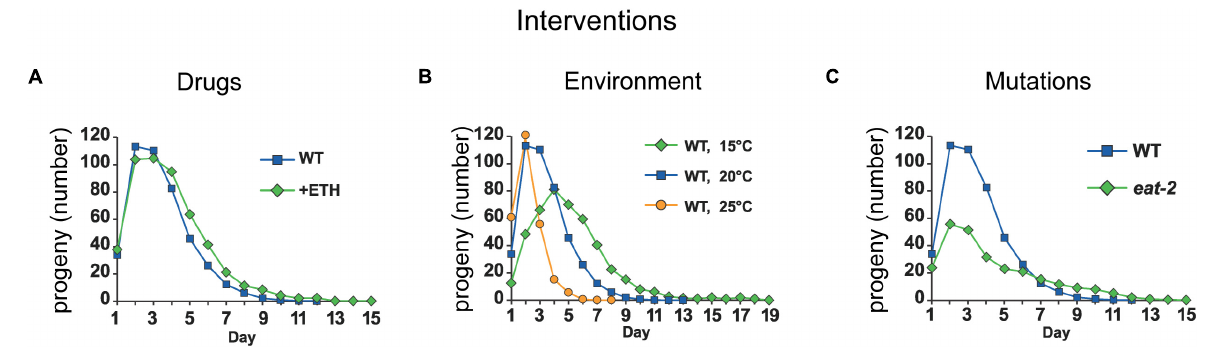
FIGURE 7 | Environmental, genetic, and pharmacological factors can delay reproductive aging. Representative interventions that prolong the reproductive span and increase late progeny production in short (24 h) mated C. elegans hermaphrodites. (A) Ethosuximide-treatment increases mid-life and late progeny production and prolongs the reproductive span in mated wild-type C. elegans . Adapted from Hughes et al. (2007). (B) Increasing the culture temperature from 20 ◦ C (blue curve) to 25 ◦ C (yellow curve) decreases late progeny production and reduces the reproductive span after peak in mated wild-type C. elegans . By contrast, reducing the culture temperature to 15 ◦ C (green curve) decreases early progeny production, increases late progeny production, increases reproductive span to peak, and extends the reproductive span after peak in mated wild-type C. elegans . Adapted from Hughes et al. (2007). (C) Mated C. elegans hermaphrodites with a mutation in eat-2 (green) display decreased early progeny production, decreased peak progeny number, increased late progeny production, and an extended total reproductive span compared to wild type. Adapted from Hughes et al.